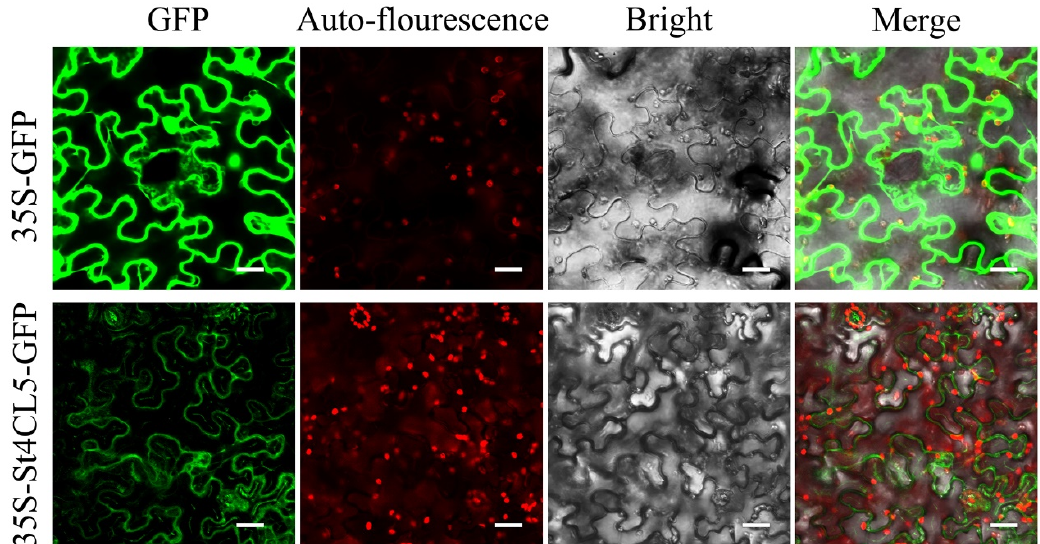
Figure 9. Subcellular localization of St4CL5 protein in potato. 35S-GFP as the experimental control was transiently expressed in tobacco leaves alone. 35S-St4CL5-GFP was the transient expression of St4CL5 and GFP fusion protein in tobacco leaves, and the subcellular location of St4CL5 protein was tested. Bars = 20 µm.